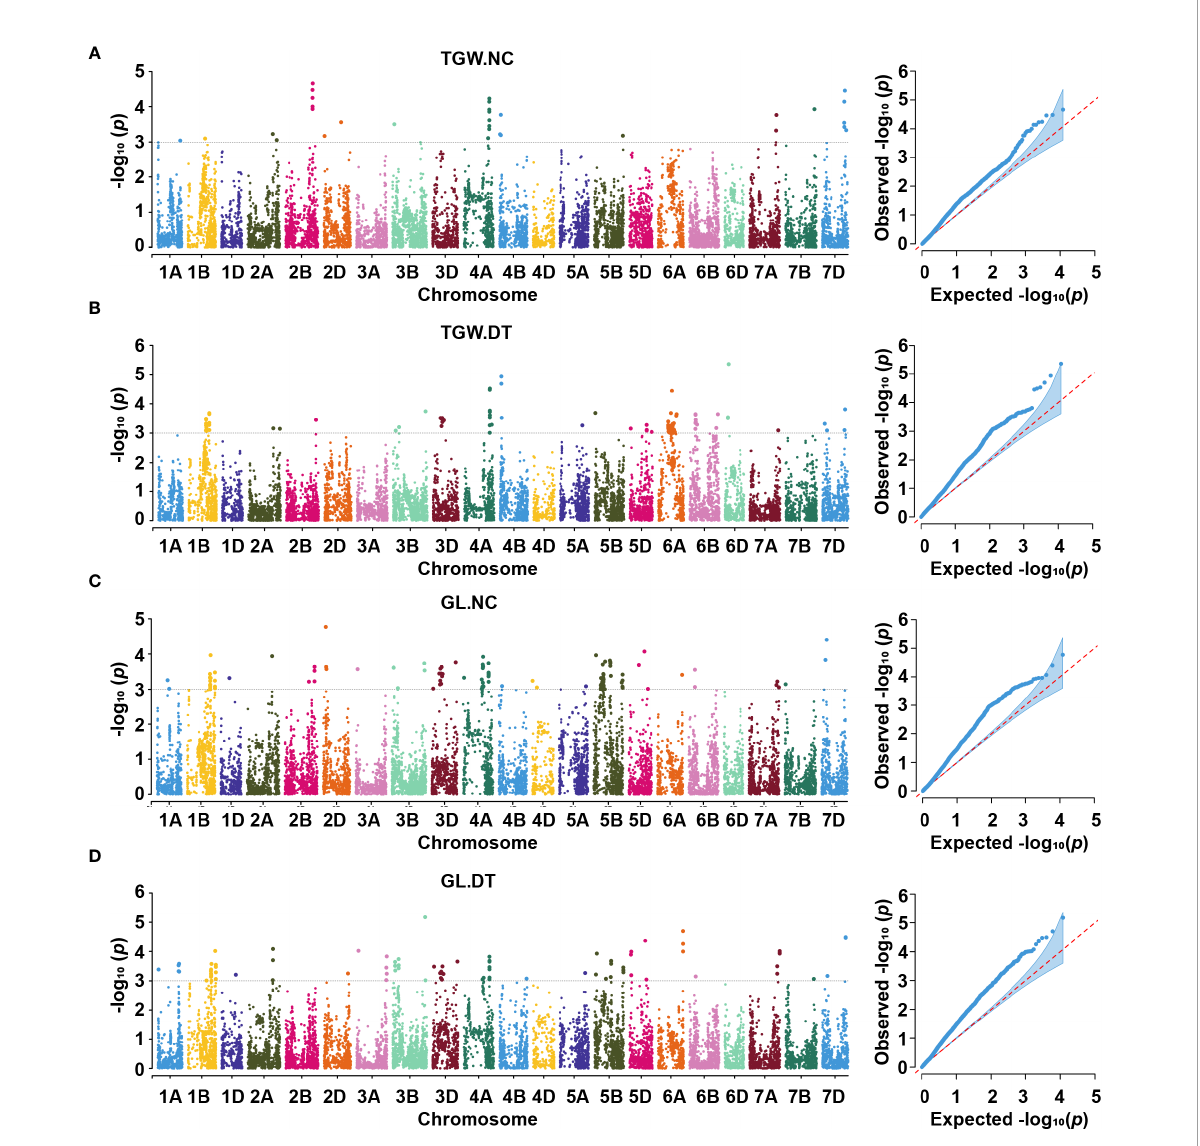
FIGURE 4 Manhattan and Q-Q plots for thousand-grain weight (A, B) and grain length (C, D) under two conditions. TGW.NC, thousand-grain weight under normal conditions; TGW.DT, thousand-grain weight under drought treatment conditions; GL.NC, grain length under normal conditions; GL.DT, grain length under drought treatment